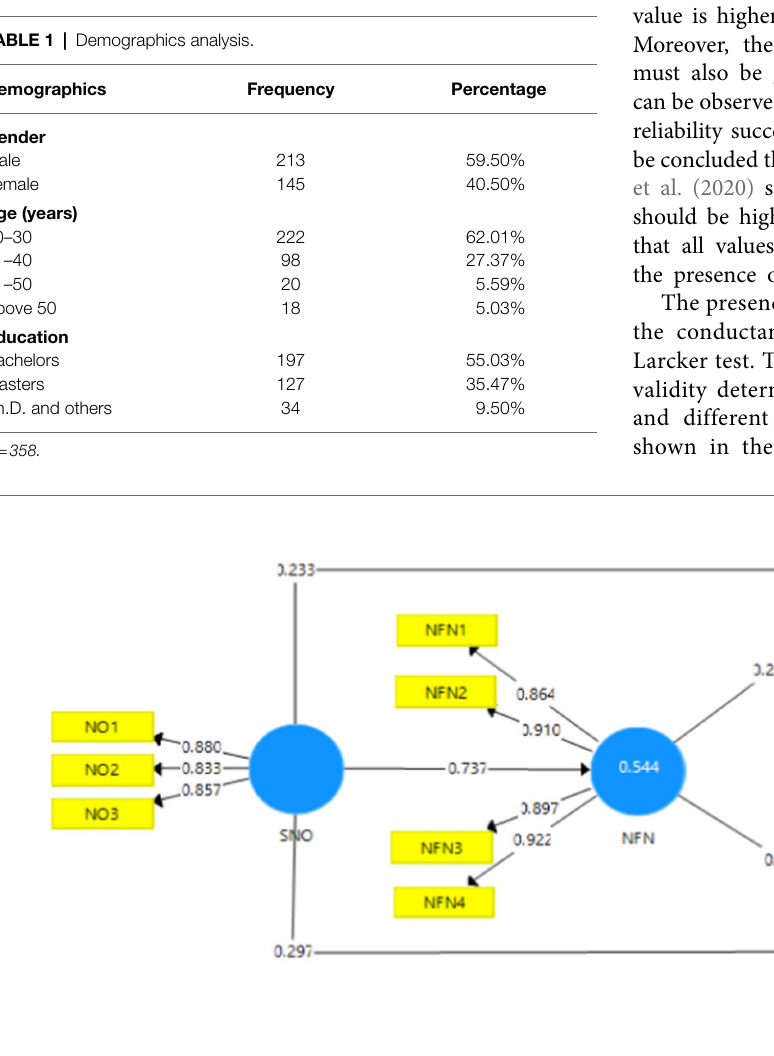
FIGURE 2 | Output of measurement model without moderation. SMO, Social Media Overload; NA, News Avoidance; NF, News Filtering; NFN, Need for